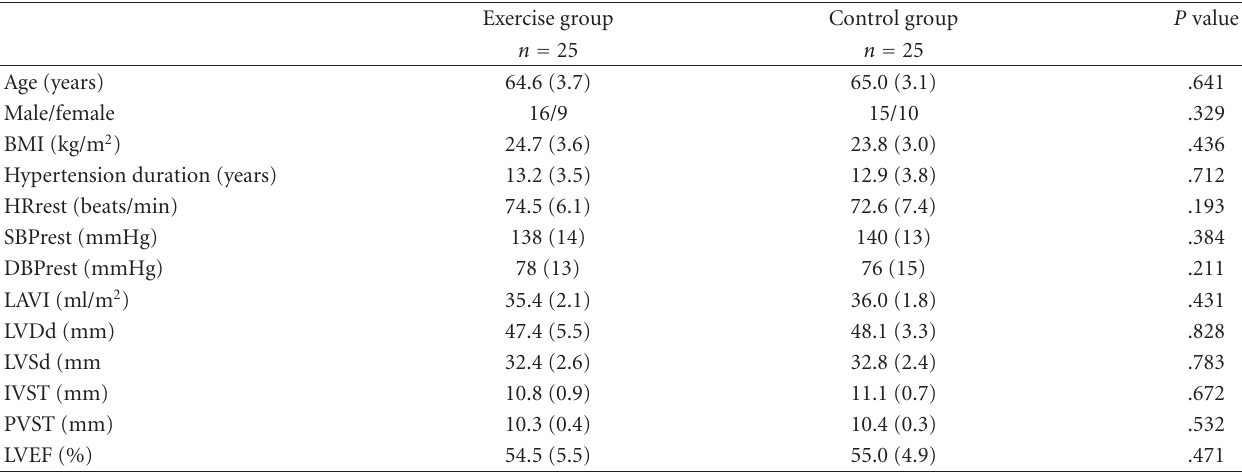
Table 1: Baseline clinical, morphological, and echographic characteristics of trained patients and untrained controls.